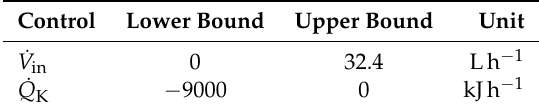
Table 3. Case study 1: Bounds on the control inputs.